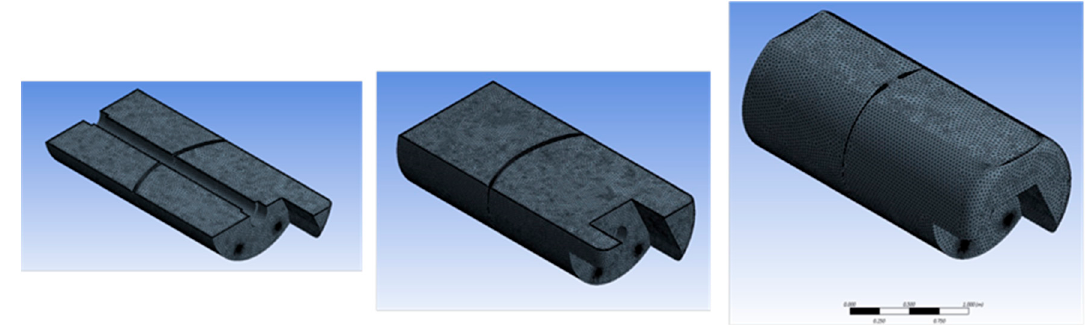
Figure 3. 3D view of 3 mesh configurations of the sprayer tank for 1000 ( left ), 2000 ( center ), and 3000 L ( right ) of water inside.